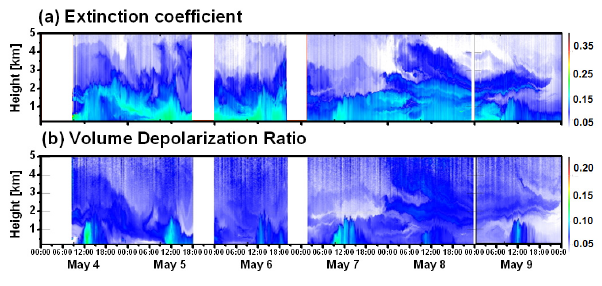
Fig. 2. Time-altitude plot of the extinction coefficient (a) and the de- polarization ratio (b) at 532nm measured from 00:00LT on 24 May to 24:00LT on 29 May